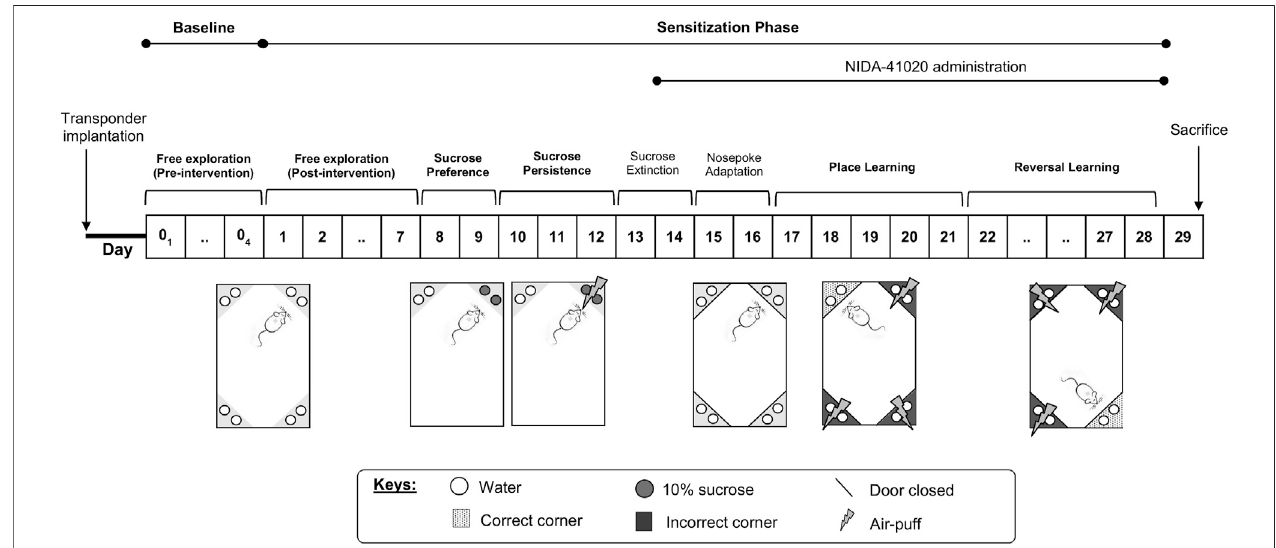
FIGURE 1 | Summary of the IntelliCage experimental